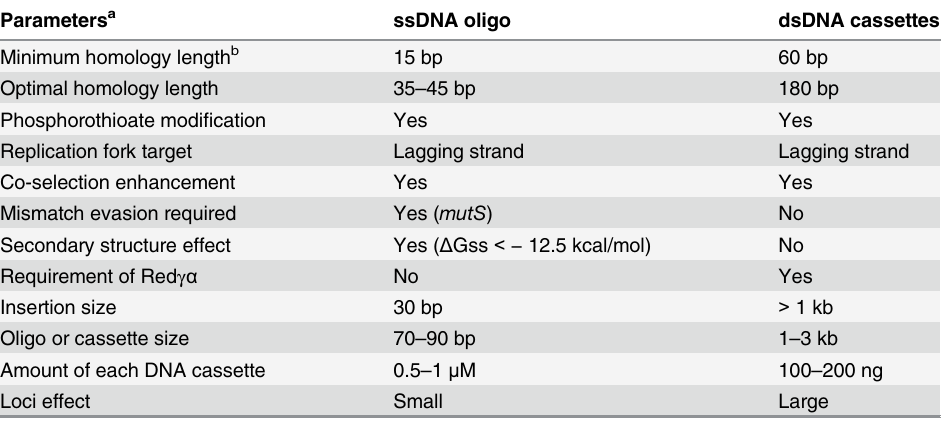
Table 1. Comparision of parameters affecting multiplex recombination of oligos and dsDNA cassettes. Parameters